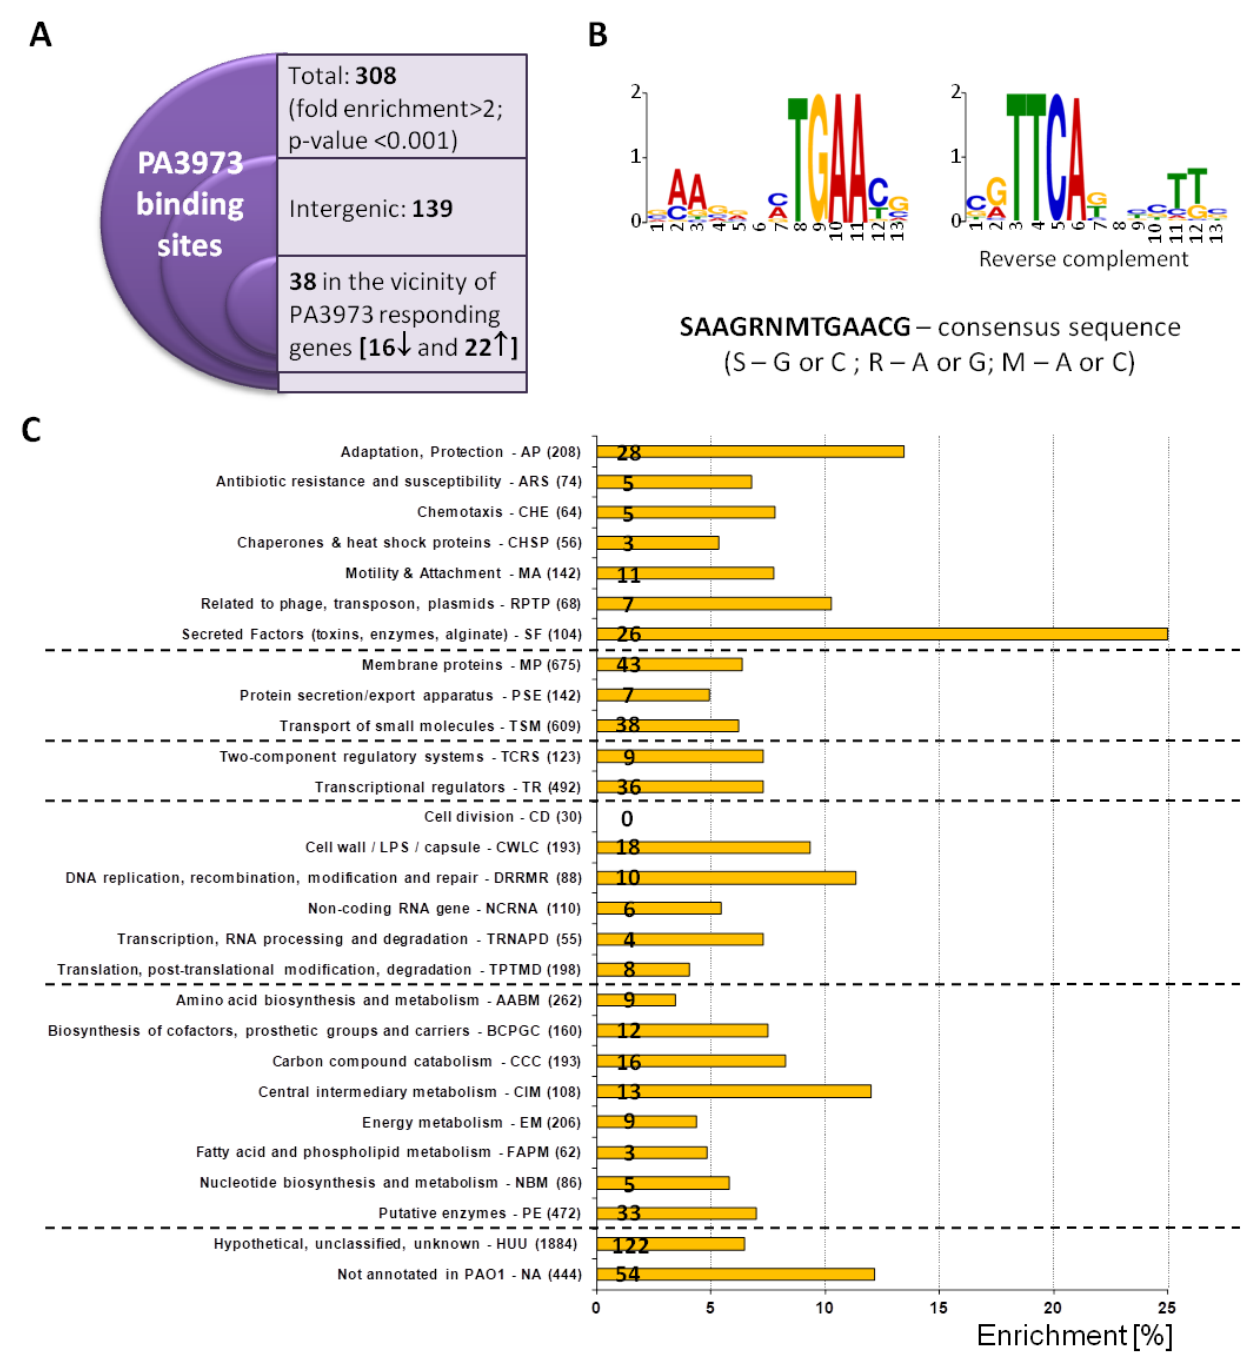
Figure 4. Identification of PA3973 binding sites in P. aeruginosa (ChIP-seq). ( A ) Cells expressing PA3973-FLAG were subjected to chromatin immunoprecipitation using anti-FLAG antibodies. Reads obtained by sequencing the ChIP DNA were mapped onto the PAO1161 genome. A gene was classified as likely to be directly regulated by PA3973 if the ChIP-seq peak summit was located in the vicinity of the start codon of the gene affected in RNA-seq by PA3973 excess. ( B ) Sequence logo of the PA3973 binding motif and its reverse complement version obtained by MEME tool [42]. The proposed consensus sequence is presented below. ( C ) Functional classification of genes likely to be affected by PA3973 binding. Bars present the enrichment of loci with PA3973 binding sites identified in ChIP-seq in the vicinity of genes and coding regions (identified genes from Tables S4 and S5), belonging to each PseudoCAP category [11]. Numbers indicate the exact number of genes belonging to each category with PA3973 binding site in their vicinity.